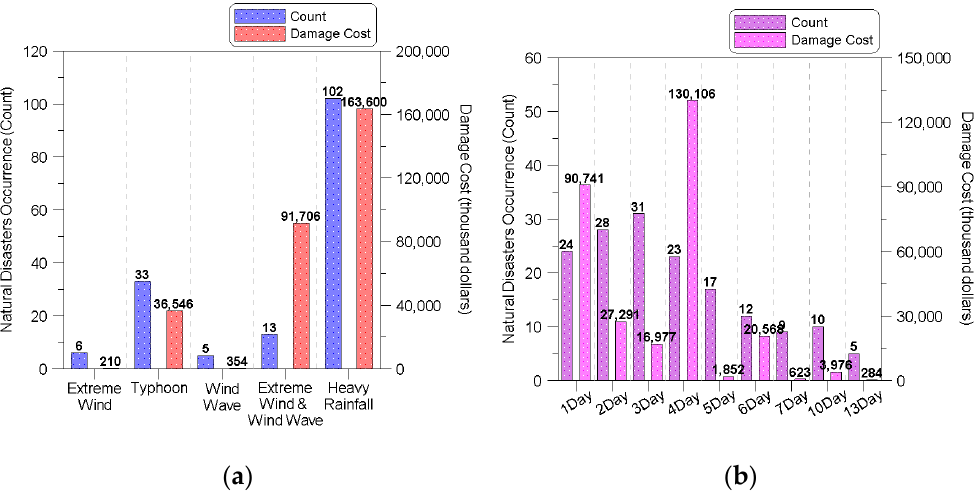
Figure 2. Status of natural disaster damage in urban areas (2010–2017): ( a ) occurrence count and damage cost by natural disaster type; ( b ) occurrence count and damage cost by length of disaster.